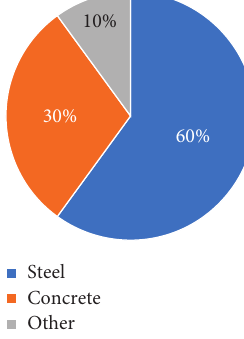
Figure 1: Structural typologies found in Portugal [1].